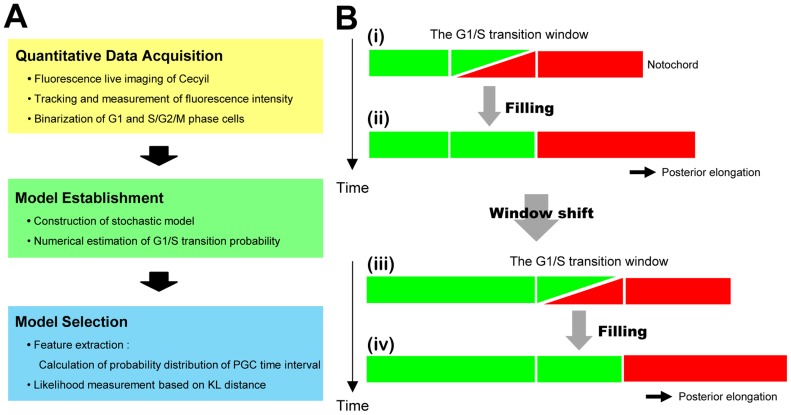
Summary of methodology and findings.(A) Schematic summary of our methodology. Our methodological approach consisted of three successive processes: 1) live imaging and image processing, 2) model establishment and 3) model selection. Each process was further divided into sub-processes, as noted in each box. (B) Schematic illustration of the regulatory mode of the G1/S transition in the developing notochord. (B-i, B-ii) Once the G1/S transition window was established between populations of anterior green (S) and posterior (G1) red cells, the G1 cells in the window stochastically transitioned into the S phase (B-i), after which the window was finally filled with green (S) cells (B-ii). (B-iii, B-iv) The next transition window was established posteriorly adjacent to the previous window. As observed in the previous cycle, an increasing number of green (S) cells filled the window as time progressed (B-iii), until the window was finally filled with green cells (B-iv).